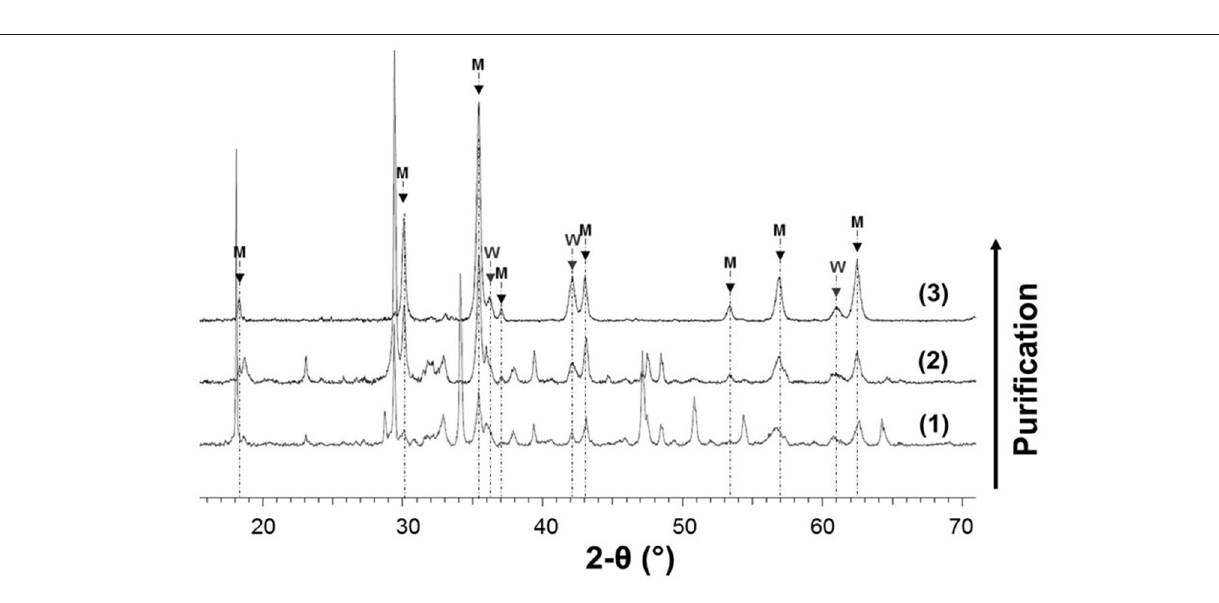
the crystallization of a significant amount of brucite, Mg(OH) 2 ( Figure 6